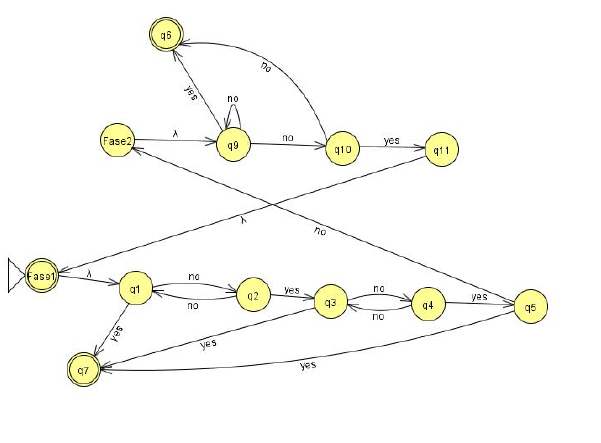
states “q7”and “q12”spell the end of the game. The state passages “yes”and “no”are the occurrences of the events represented by the states diagram.